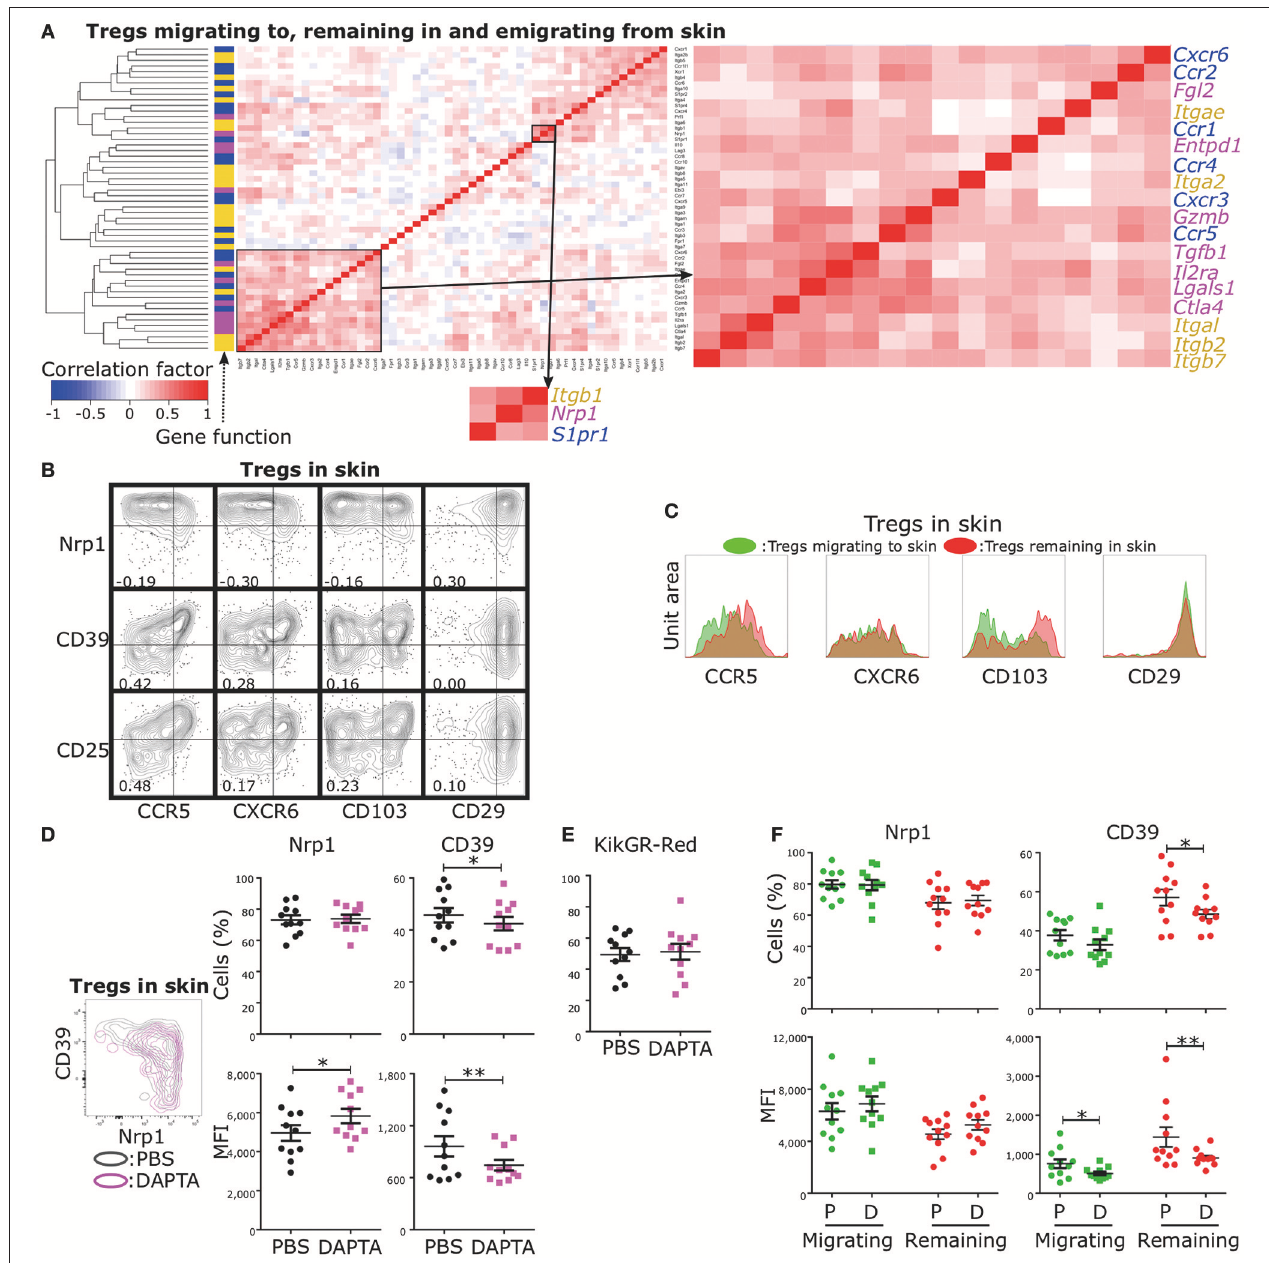
FIGURE 5 | Identification of migration-related molecules influencing functional phenotypic diversity of skin Tregs. (A) Cross-correlation analysis of the expression profiles of genes related to Treg function (magenta), migration (blue), and adhesion (yellow). scqPCR data were formed by concatenating the data of the three Treg populations (Tregs migrating to, remaining in, and emigrating from skin). Colors in cells indicate positive (red) or negative (blue) correlations. Clustering was performed by the Manhattan distance and group average method. (B) Nrp1, CD39, CD25, CD29, CD103, CXCR6, and CCR5 protein expression by Tregs in skin. FCM data are representative of three independent experiments. Lines in plots indicate boundaries between positive and negative cells. (C) Replicative data of CD29, CD103, CXCR6, and CCR5 protein expression by Tregs migrating to and remaining in skin ( n = 3). (D,E) Nrp1 and CD39 expression (D) and Proportions of KikGR-Red + cells (E) in skin Tregs of mice treated with PBS (control) or DAPTA. (F) Nrp1 and CD39 expression by Tregs migrating to and remaining in skin of mice treated with PBS or DAPTA.